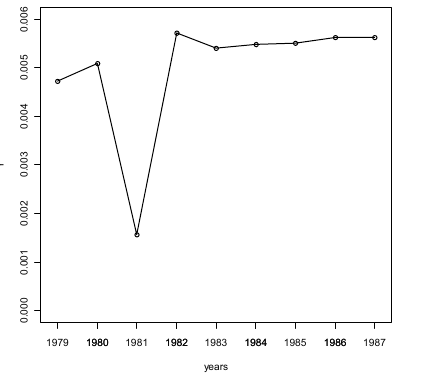
Figure 14 – Time series of municipality num- ber 2184.